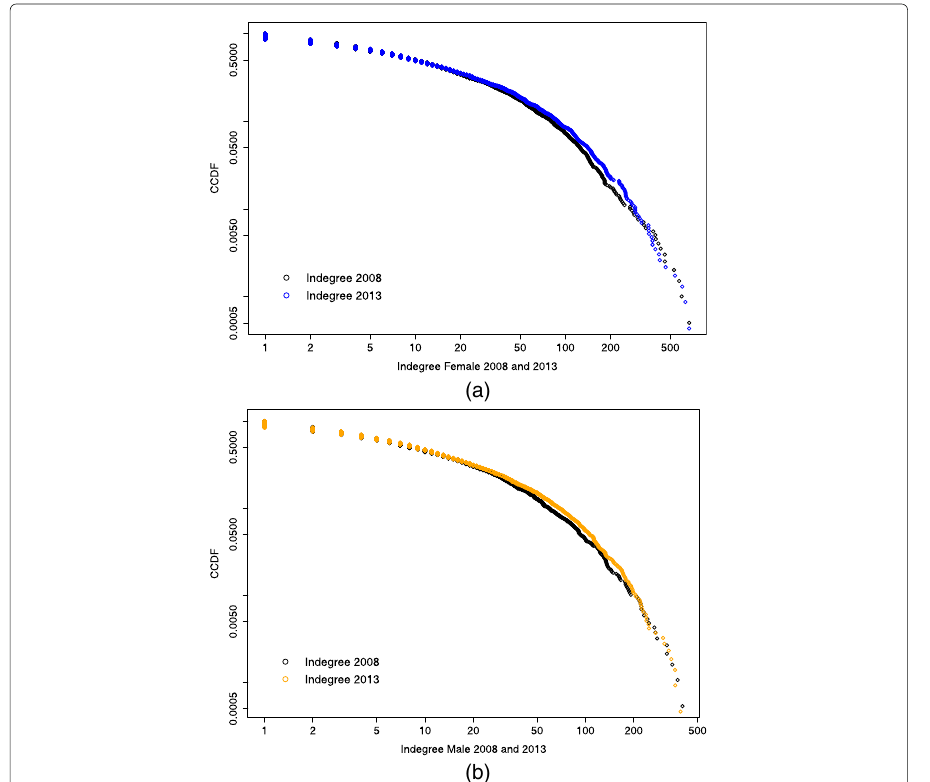
Fig. 7 Female and male indegree distribution compared by year. Complementary cumulative distribution function (CCDF) on log-log scale of the female (a) and male (b) indegree distribution for the years 2008 and 2013 H 0 : the power law fitted model is a plausible option H 1 : the power law fitted model is not a plausible